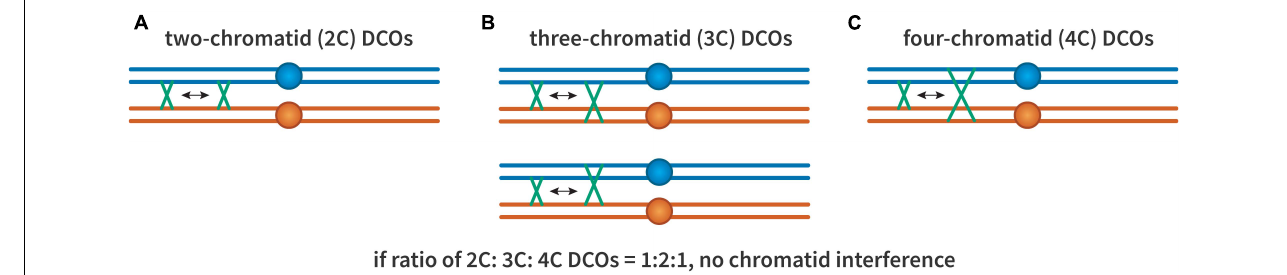
FIGURE 3 | Chromatid interference. Each panel illustrates two crossovers on one bivalent, with each line representing one double-stranded DNA chromatid. The first (leftmost) crossover is the same in all cases, occurring between the two inner chromatids. (A) A 2-chromatid DCO. (B) Two possible 3-chromatid DCO configurations. (C) A 4-chromatid DCO. If there is no chromatid interference, the ratio of 2:3:4 should be